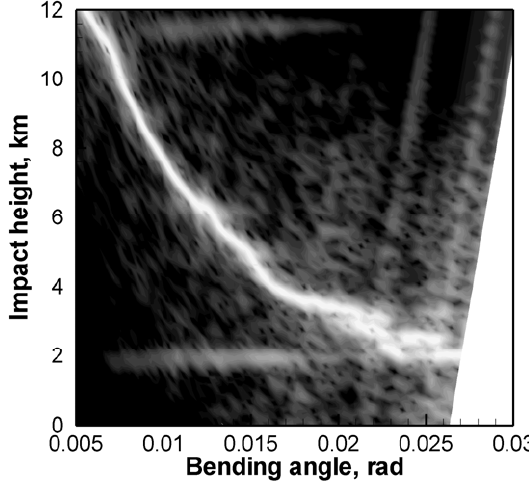
Fig. 2. Occultation event observed on 30 September 2007, UTC 21:47, 65.93S 87.20E. Reflection and multipath near the Antarctic. Figure 2. Occultation event observed on September 30, 2007, UTC 21:47, 65.93S 87.20E. 3 Reflection and multipath near the Antarctic. 4